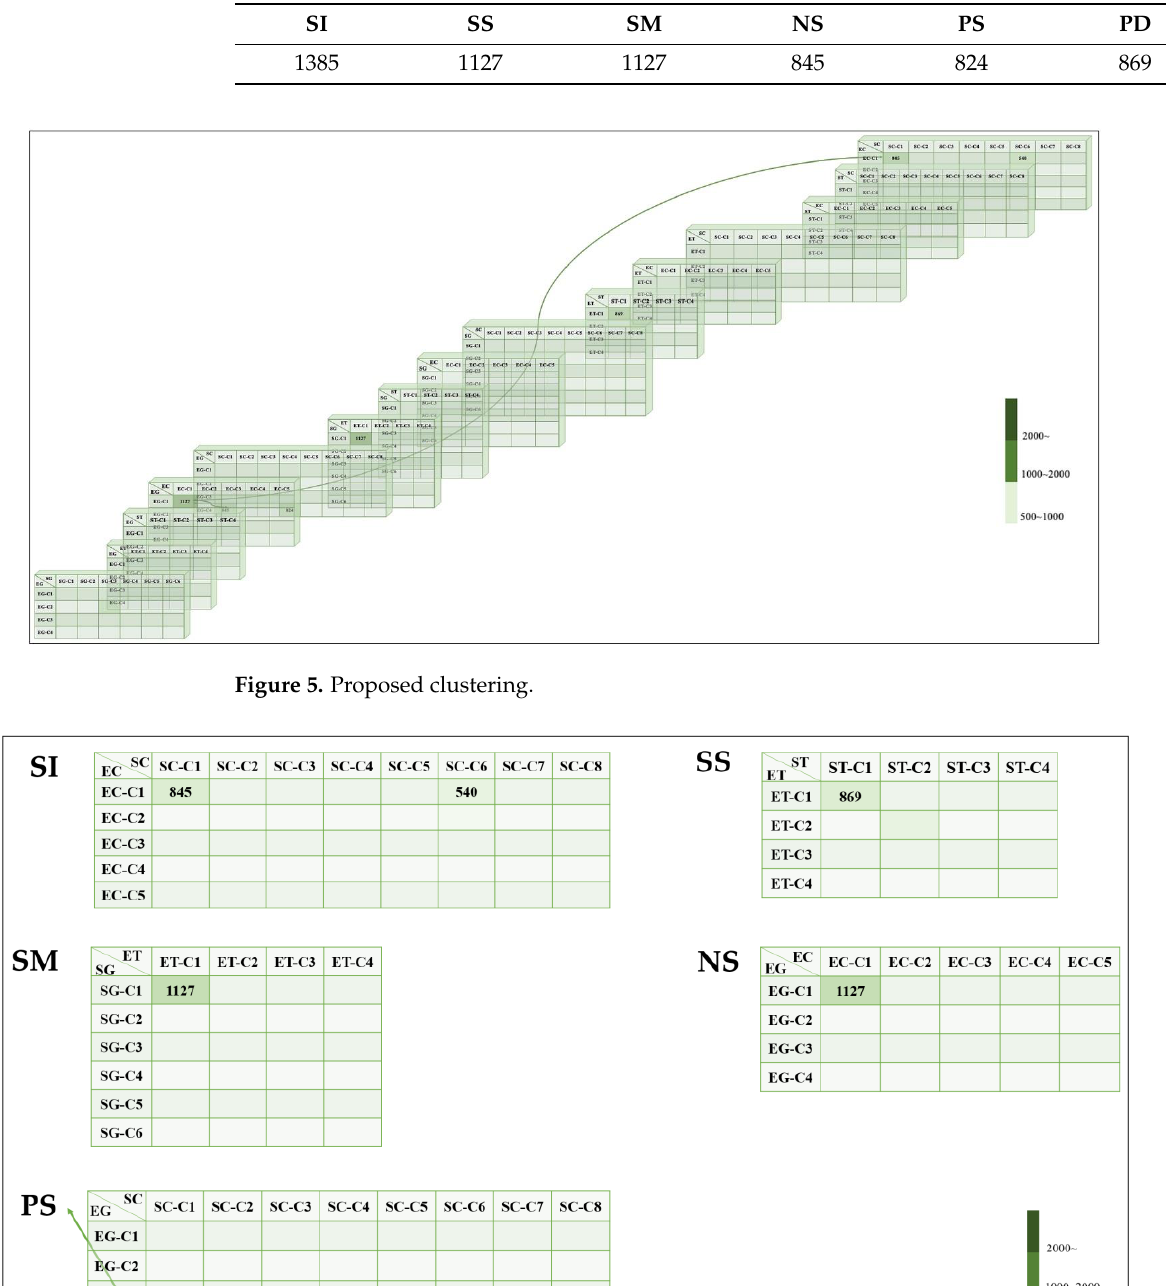
Figure 6. Detailed information on the proposed clustering. Table 1. Proposed picking grouping.